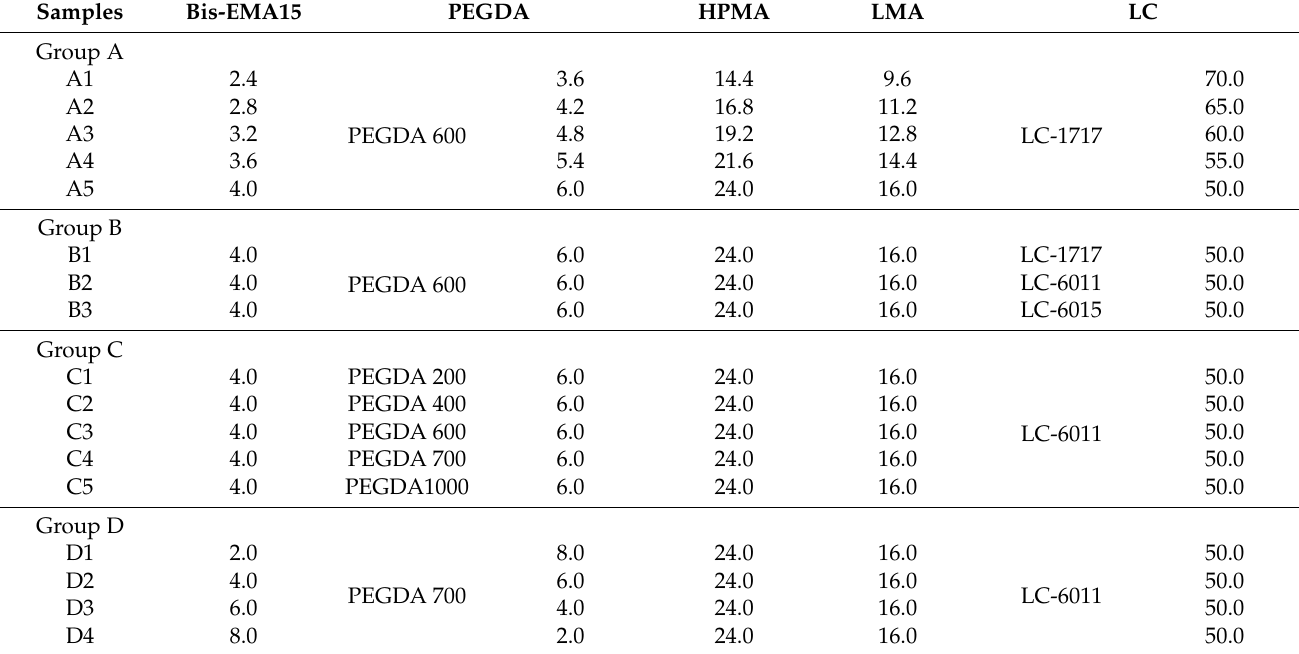
Figure 8. SEM photos of PDLC films with different monomer (Bis-EMA15/PEGDA700) content ratios: D1 (1:4), D2 (2:3), D3 (3:2), and D4 (4:1).